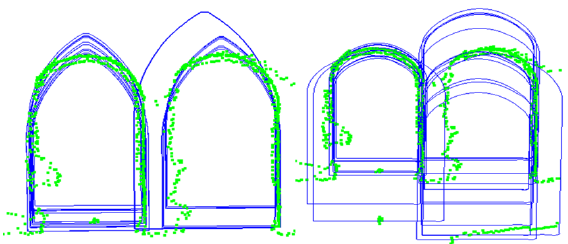
Figure 6: Multiple detections of a half-circular and a gothic win- dow models.